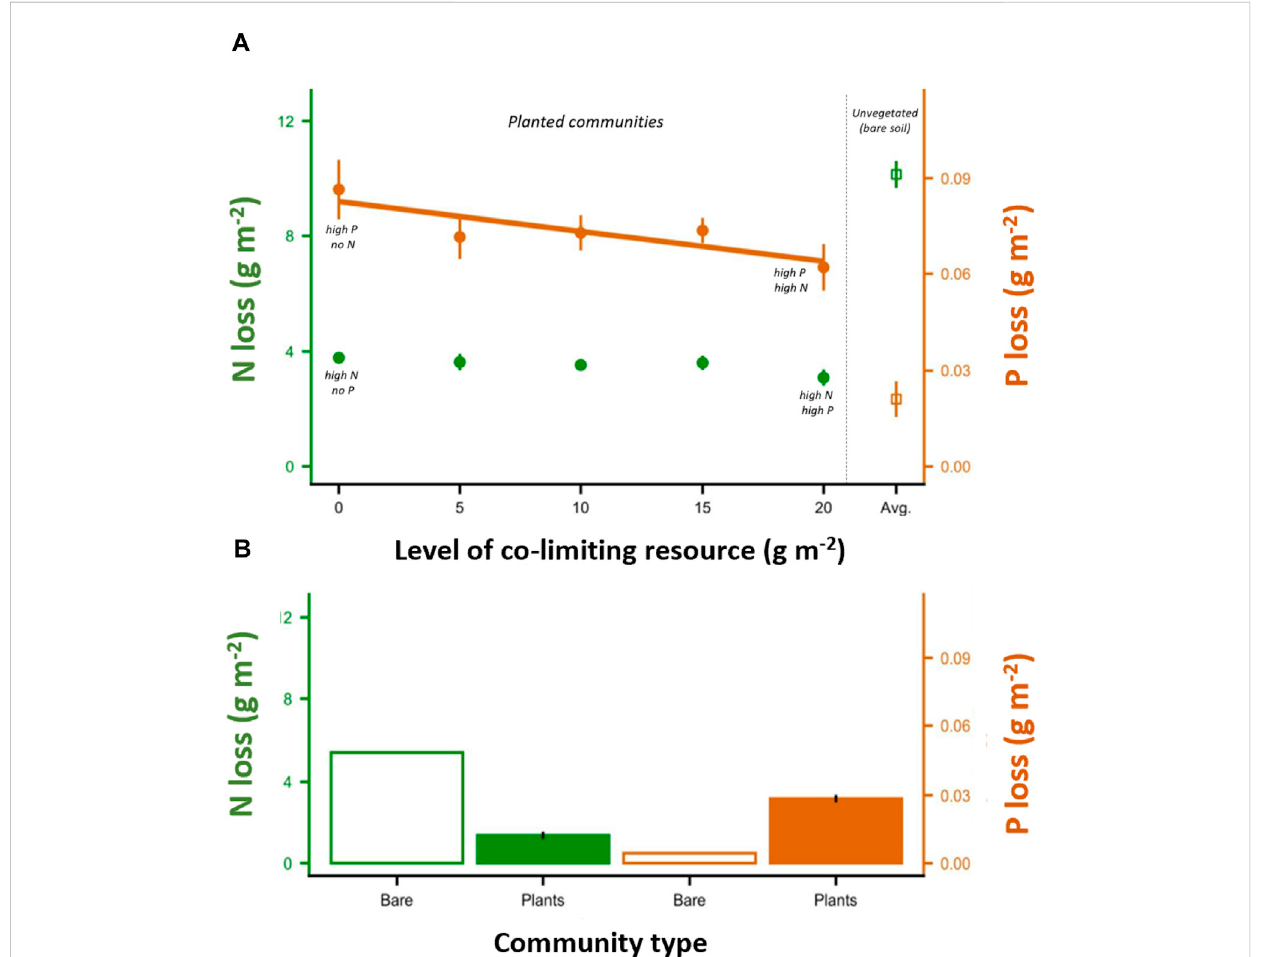
FIGURE 1 Nutrient loss with shifting levels of co-limiting resources, for high P with increasing levels of N and for high N with increasing levels of P. For P, increasinglevelsofNreducesPlevelsinsubterraneanleachate (A) .Incontrast,NlevelsinleachateareunaffectedbyincreasedlevelsofPaddition (A) .For unvegetated mesocosms, N losses are signi fi cantly higher compared to vegetated mesocosms, indicating the importance of plant uptake on N (A,B) . Unexpectedly, P levels in leachate were lower in mesocosms lacking vegetation (A,B) . Error bars represent = 1 SE, and trendlines show signi fi cant linearrelationships.In (A) ,N=9formesocosmswithplants,andN=5forbaresoilmesocosms.In (B) ,N=9formesocosmswithplants,andN=1forbare